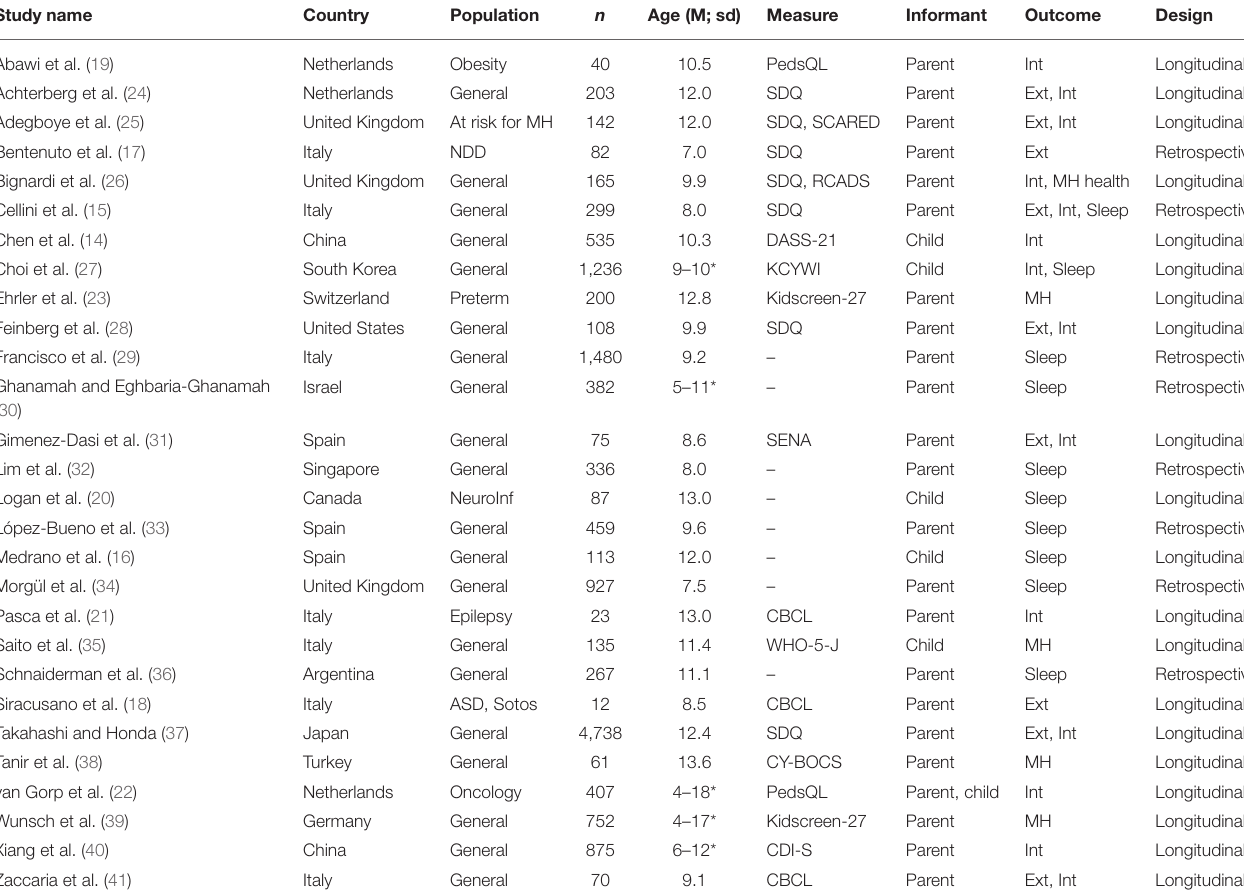
TABLE 2 | Characteristics of studies included in the quantitative